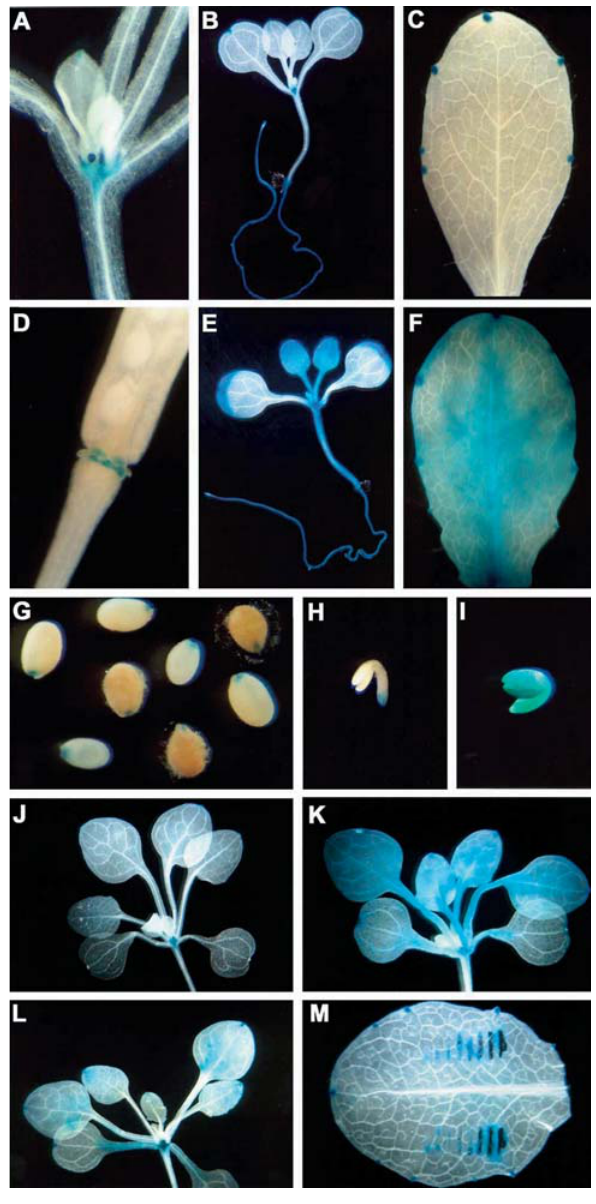
Figure 2 - Expression pattern of AtchitIV promoter in A. thaliana plants. A-D and G-M show representative GUS activity in transgenic plants har- bouring promoter constructs at positions -1923, -1500, -1083. E and F show representative GUS activity in transgenic plants harbouring pro- moter constructs at positions -600 and -300. Histochemical localisation of GUS activity in Arabidopsis transgenic plants: A) Seedling - detail of the meristematic region (40X); B) Ten day-old seedling (6,5X); C) Leaf (10X); D) Silique - detail of the floral receptacle (35X); E) Ten day-old seedling ( ∆ 300 promoter) (6,5X); F) Leaf ( ∆ 300 promoter) (10X); G) Seed from different developmental stages (globular - mature stage) (40X); H) Embryo - late torpedo stage (40X); I) Embryo - mature stage (40X); J) Seventeen days-old control plant (6,5X); K) Seventeen day-old UV irradi- atedplant(6,5X);L)Seventeenday-oldsalicylicacidsprayedplant6,5X); M) Wounded leaf